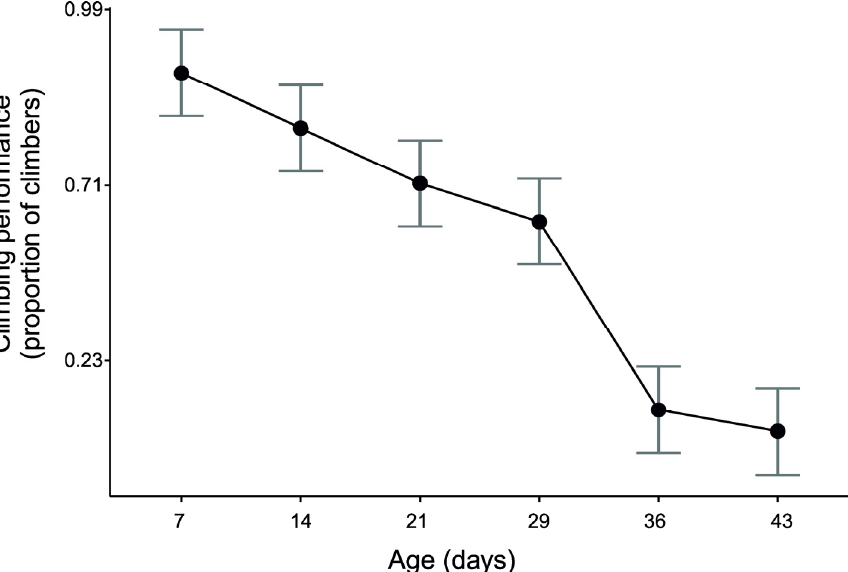
Figure 3. Males of Drosophila melanogaster showed systematic deterioration of climbing performance with age. Climbing performance was measured by calculating the proportion of flies that climbed out of a vertical column during a 140-s climbing assay (see Figure 1b for technical measurement details). The means (95% CIs) were estimated with a general linear mixed model performed on transformed data. For convenience, values on the vertical axis are shown as proportion units after inverse transformation.